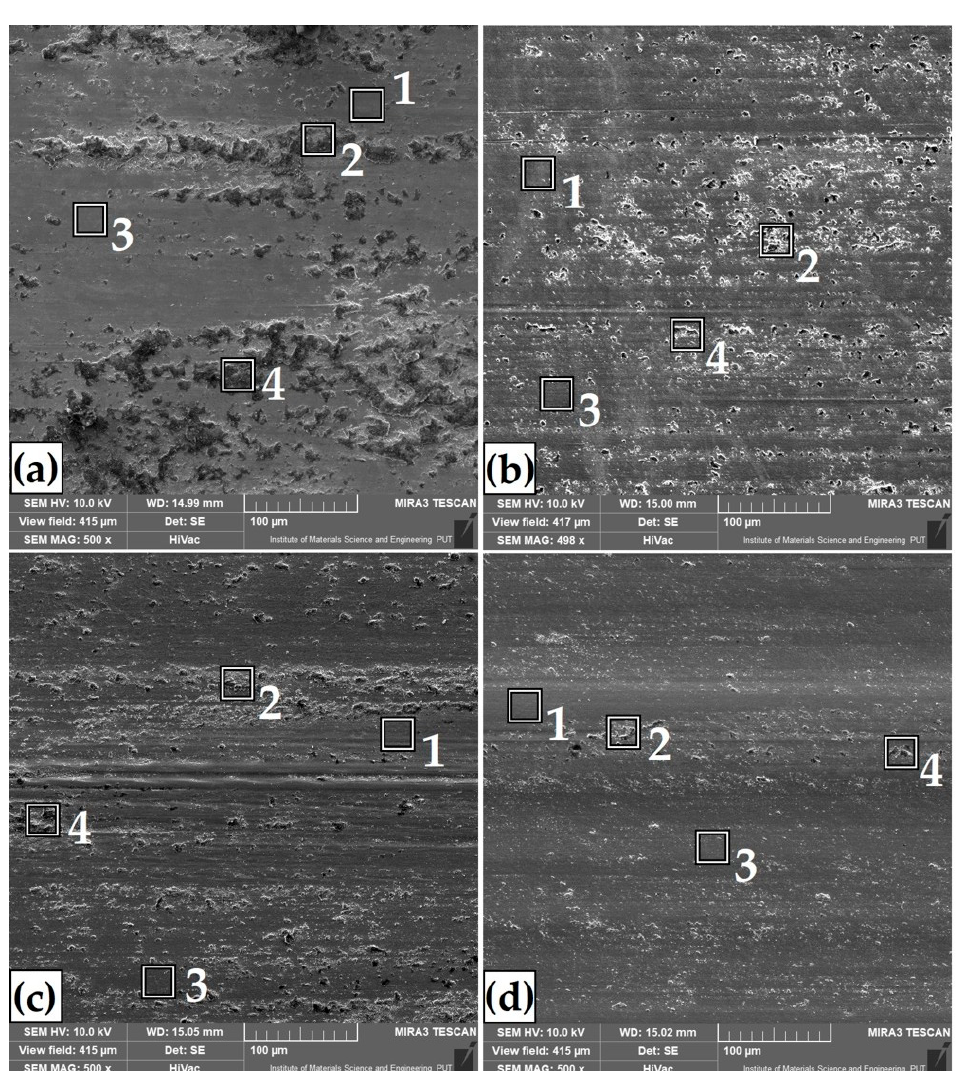
Figure 9. Surfaceconditionsafterwearresistancetestsofdiffusionboronizedlayer( a ),andFeB-Fe 2 B-Fe 3 (B,C) Figure 9. Surface conditions after wear resistance tests of diffusion boronized layer ( a ), and FeB-Fe 2 B- layers produced by laser processing using 76 kW / cm 2 ( b ), 115 kW / cm 2 ( c ), and 153 kW / cm 2 ( d Fe 3 (B,C) layers produced by laser processing using 76 kW/cm 2 ( b ), 115 kW/cm 2 ( c ), and 153 kW/cm 2 ( d ).